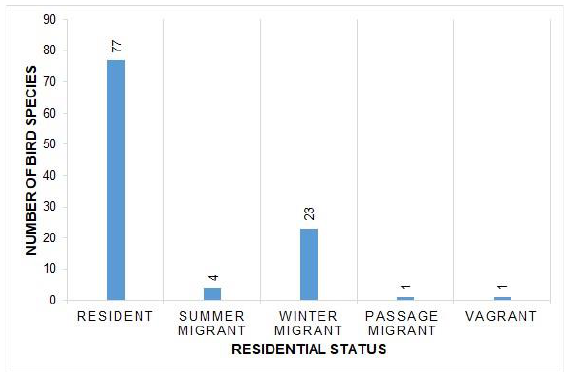
Figure 2. Residential status of different bird